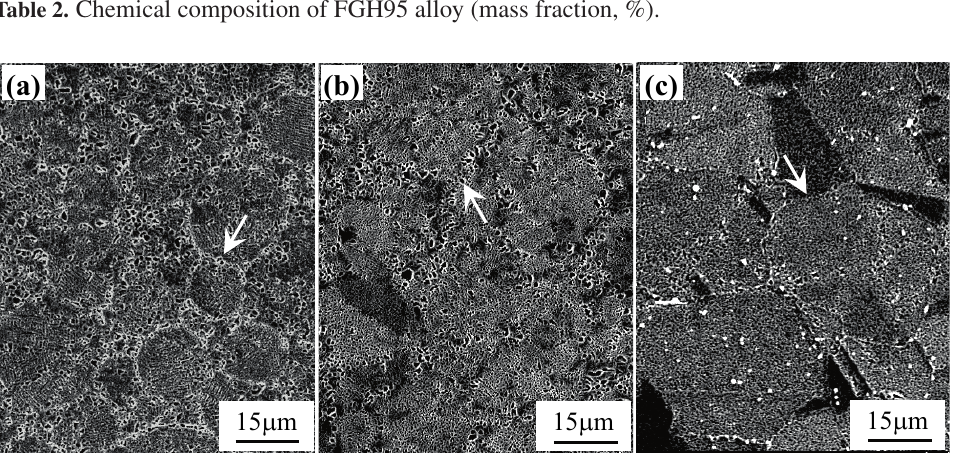
Table 2. Chemical composition of FGH95 alloy (mass fraction, %).